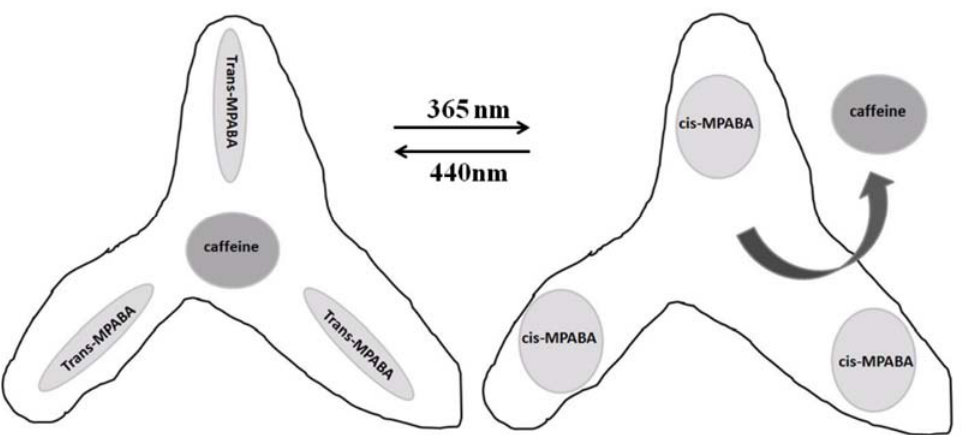
Figure 20. Schematic photo-regulated release and uptake of